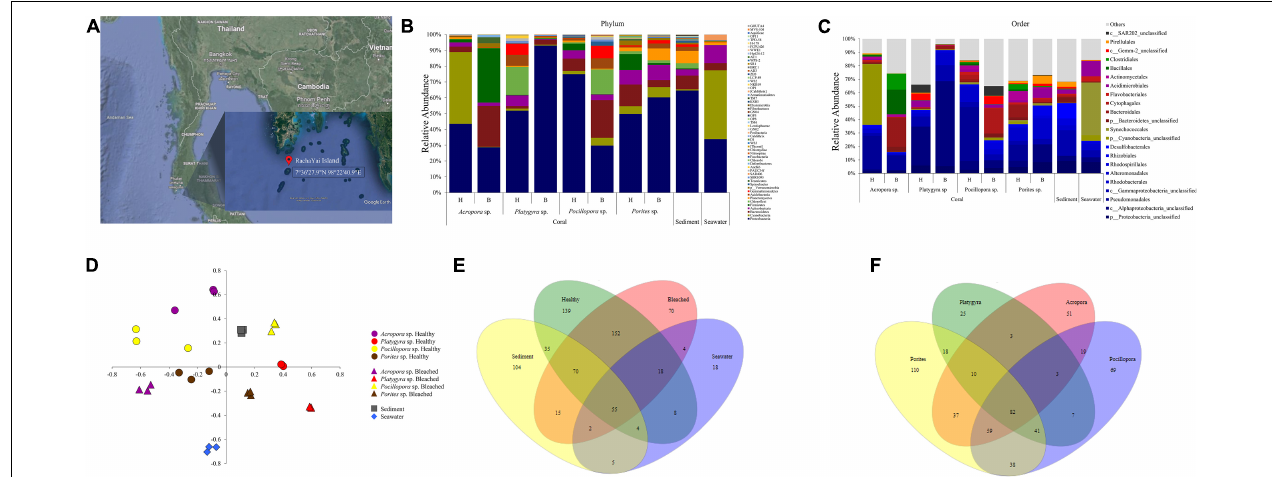
FIGURE 1 | (A) Map representing sampling site of Racha Yai Island in the Andaman Sea; average bacterial compositions in coral, sediment, and seawater samples at (B) phylum level and (C) order level; (D) their non-metric multidimensional scaling analyses based on ThetaYC index at genus level; and Venn diagrams showing the numbers of shared and unique OTUs (E) among healthy corals, bleached corals, and surrounding sediment and seawater; and (F) among four coral species Acropora humilis , Platygyra sp., Pocillopora damicornis , and Porites lutea . In panel C , “Others” represent order OTUs with < 1% abundance. For OTU classification where order could not be identified, the deepest classification level was given (abbreviated p for phylum and c for class).